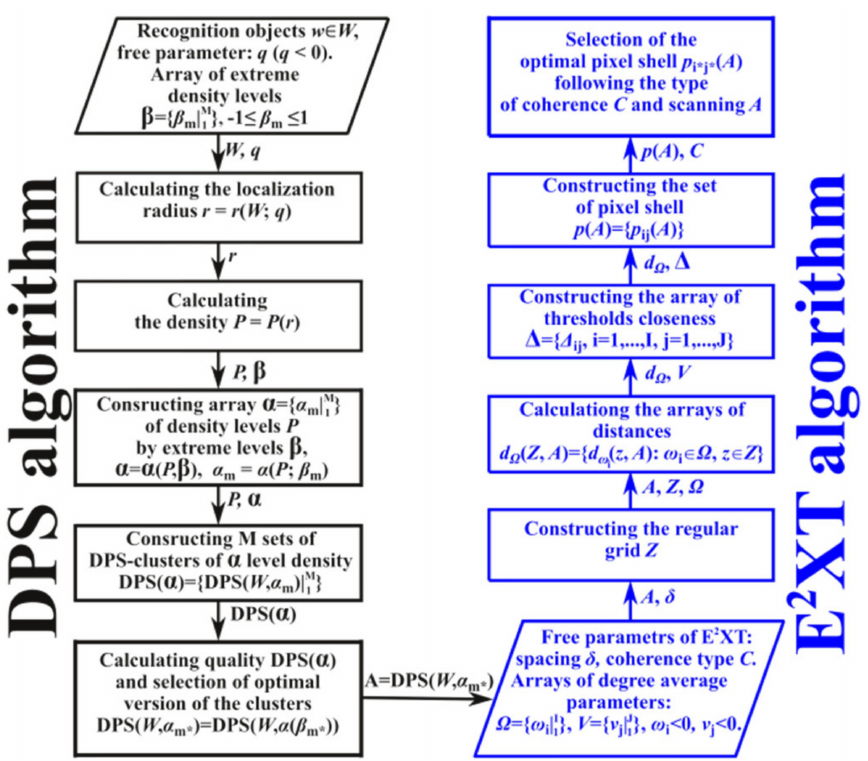
Figure 1. The flow chart of system-analytical FCAZ method. Black blocks—DPS algorithm steps; blue blocks—E 2 XT